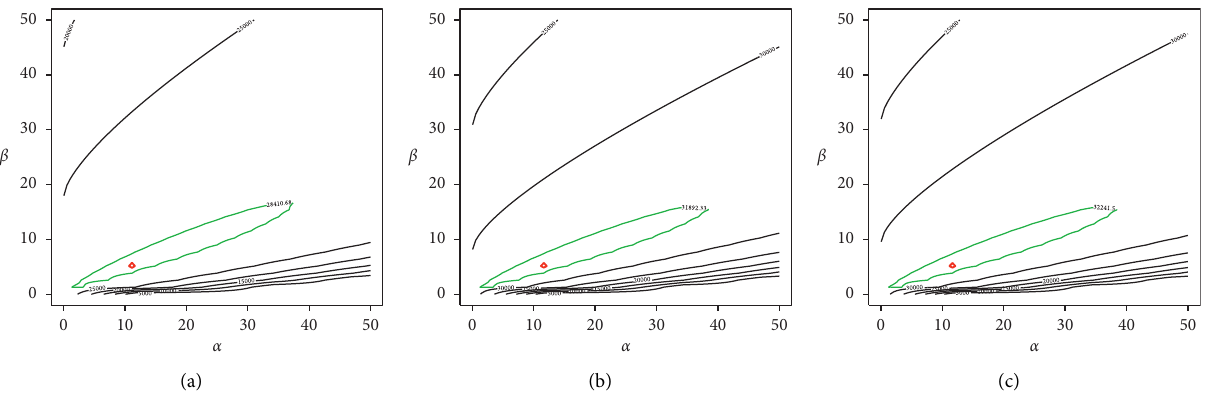
Figure 2: Plots of the monitoring MCMC algorithm where α and β are estimated. Scheme 1 at R � 59 points is used and t n � 60. (a, d) Trace plots of 􏽢 α and 􏽢 β at the transient period of 10000 iterations. (b, c) Summary of the MCMC analysis for 􏽢 α and 􏽢 β . (e, f) Histograms of 􏽢 α and 􏽢 β for scheme 1.